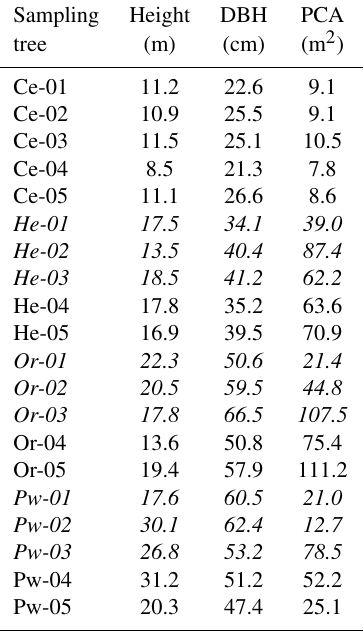
Table 1. Tree height (m), diameter at breast height (DBH) (cm) and projected crown area (PCA) (m 2 ) for all eastern white cedar (Ce), eastern hemlock (He), red oak (Or) and eastern white pine (Pw) trees sampled for bulk soil water, xylem water, soil water content and mobile soil water. Soil surrounding trees indicated in italics was sampled for soil water content and mobile soil water as reported in Snelgrove et al.